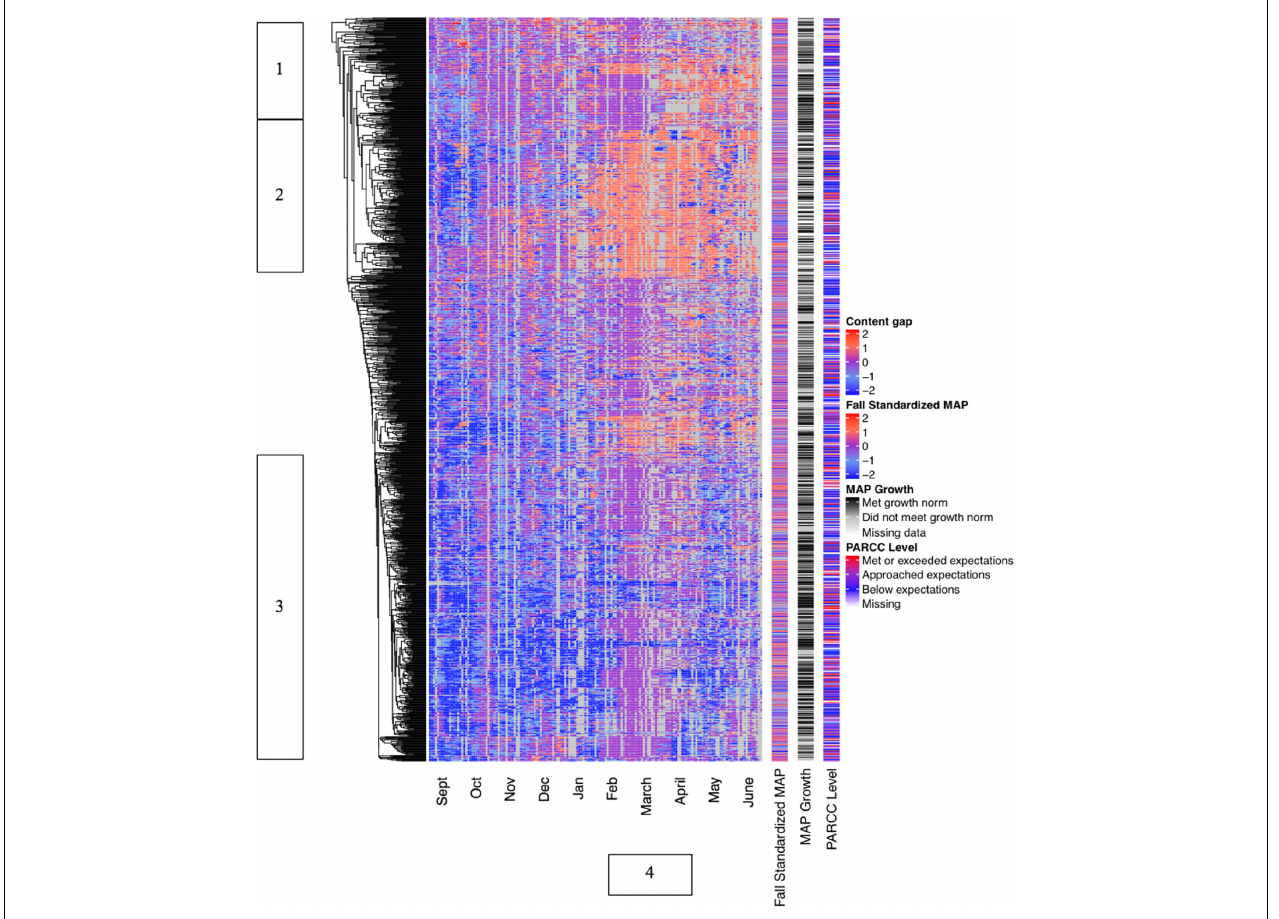
FIGURE 5 | Content gap displayed